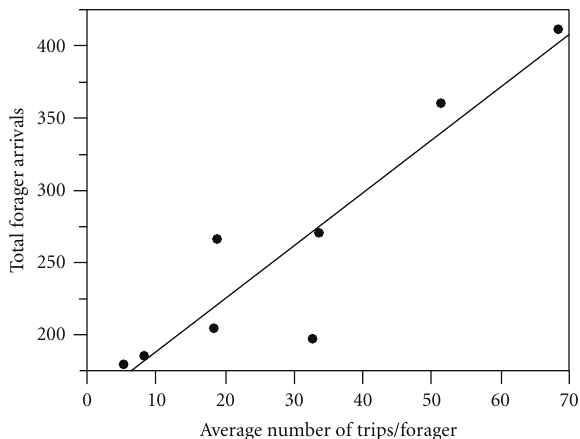
Figure 4: The total number of arrivals of marked foragers, a meas- ure of colony-wide foraging e ff ort, at the training station during the pretesting and testing phases as a function of the average number of trips per forager.